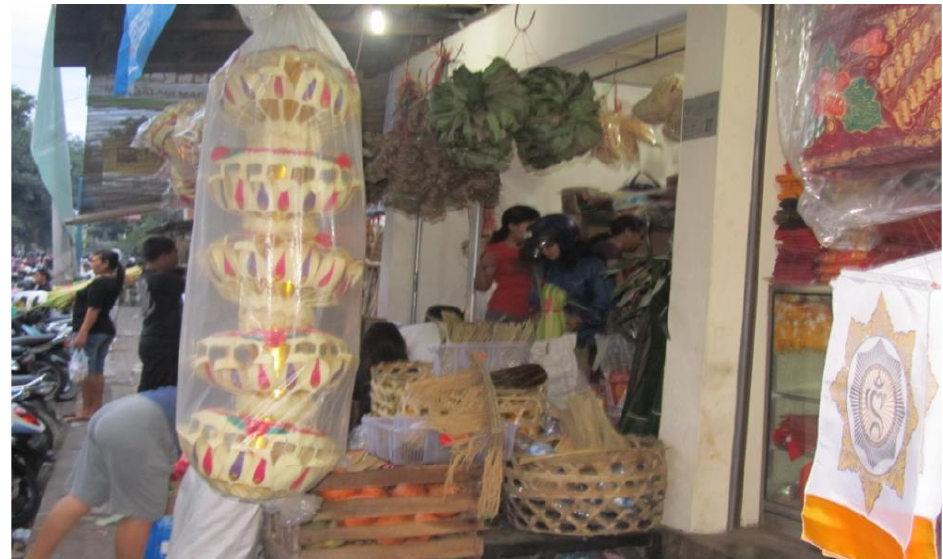
Fig.2: Merchant Seller of Upakara materials in Ketapian Market; Source: author documentation and the Empowering Institute of LPD of Bali Province,